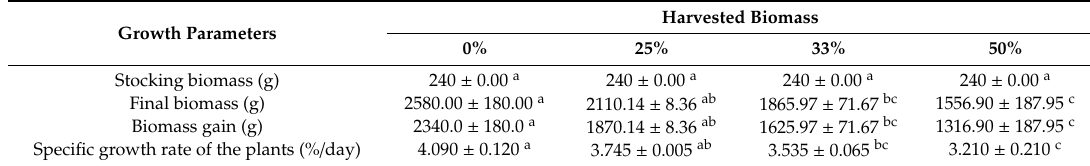
Table 4. Growth performance of Nasturtium o ffi cinale in integrated recirculating aquaponic systems under di ff erent harvesting regimes.